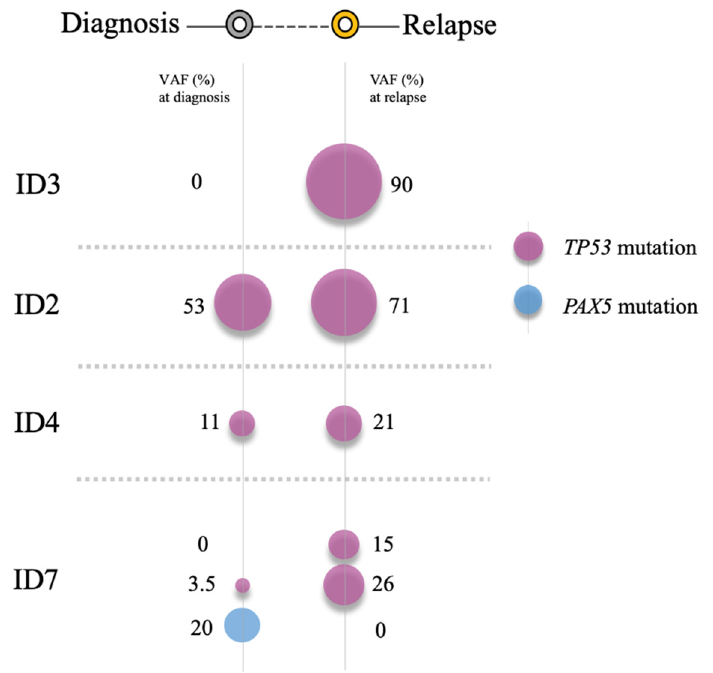
Figure 5. Clonal changes of mutations detected in paired diagnostic/relapse samples. Patient ID2 and Patient ID4 retained TP53 mutations, thereby increasing their mutational burden. Patient ID7 acquired a TP53 mutation at relapse and maintained another in TP53 from diagnosis, and showed a